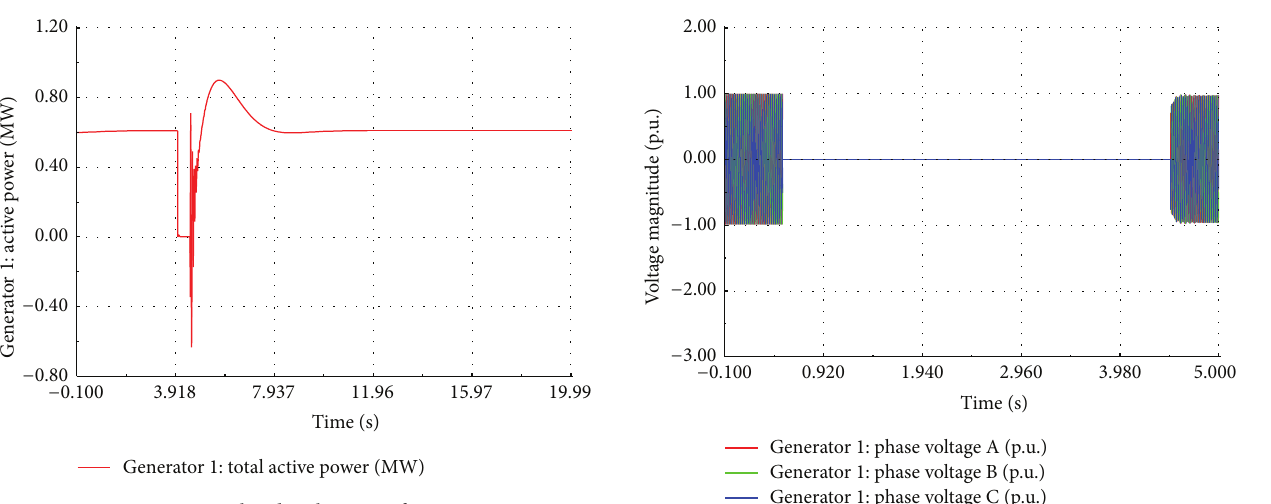
Figure 14: Simulated real power of FSWEG1.